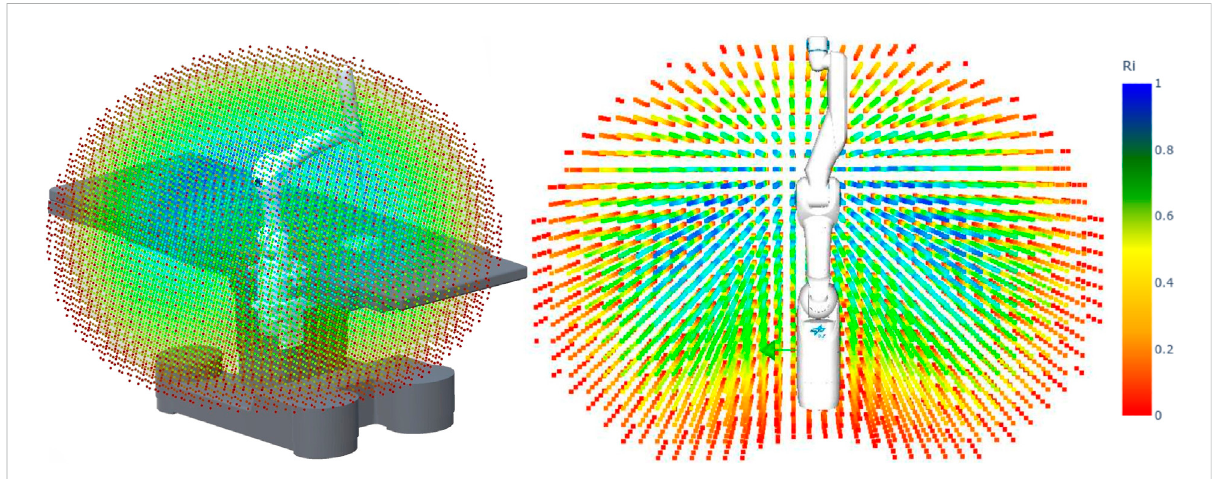
FIGURE 2 Capability mapfortheDLRMIROrobotarm.ThereachabilityindexisrepresentedinHSVcolorscale,withredbeingzero(lowdexterity regions) and blue being one (high dexterity